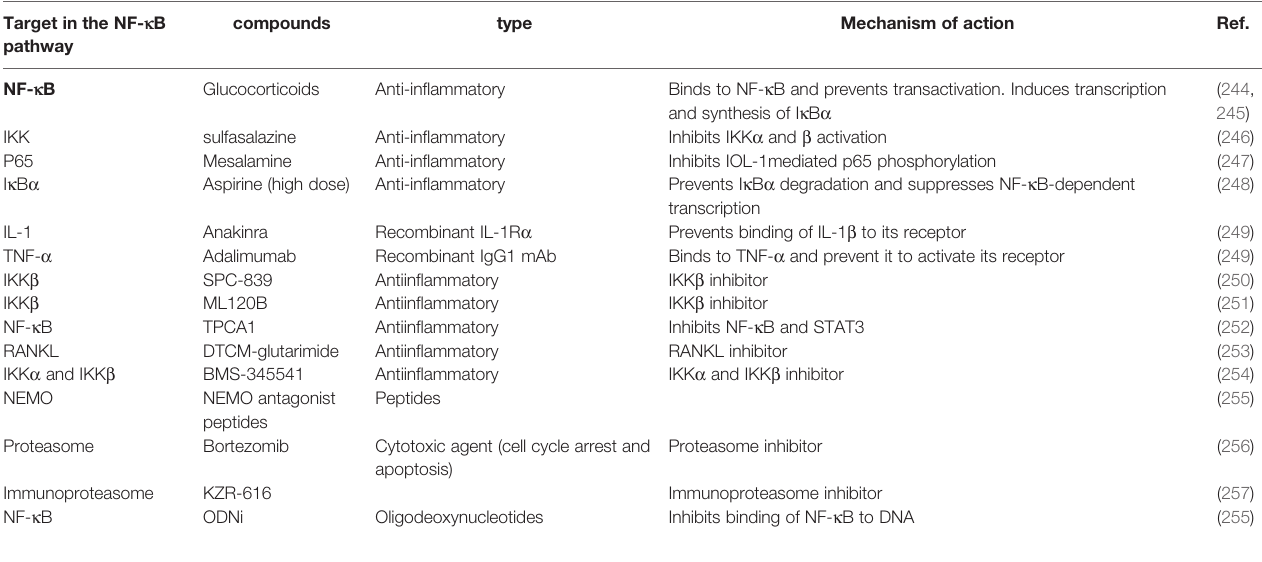
TABLE 3 | Therapeutic treatments targeting the NF- k B